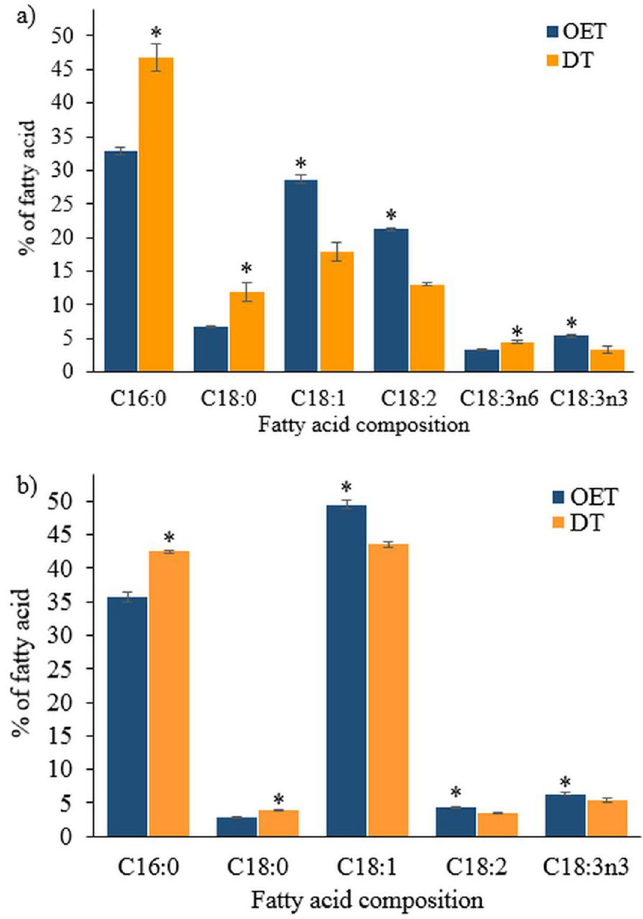
Figure 2. The fatty acid composition of ( a ) C. vulgaris UMT-M1 and ( b ) M. gracile SE-MC4 obtained from oil extraction-transesterification (OET) and direct-transesterification (DT) methods. The percent of fatty acid for OET and DT methods is of total oil content and total FAMEs, respectively. Asterisk (*) indicates significance higher among the same fatty acid according to t -test at p = 0.05. Data shown as the mean ± SD, n =